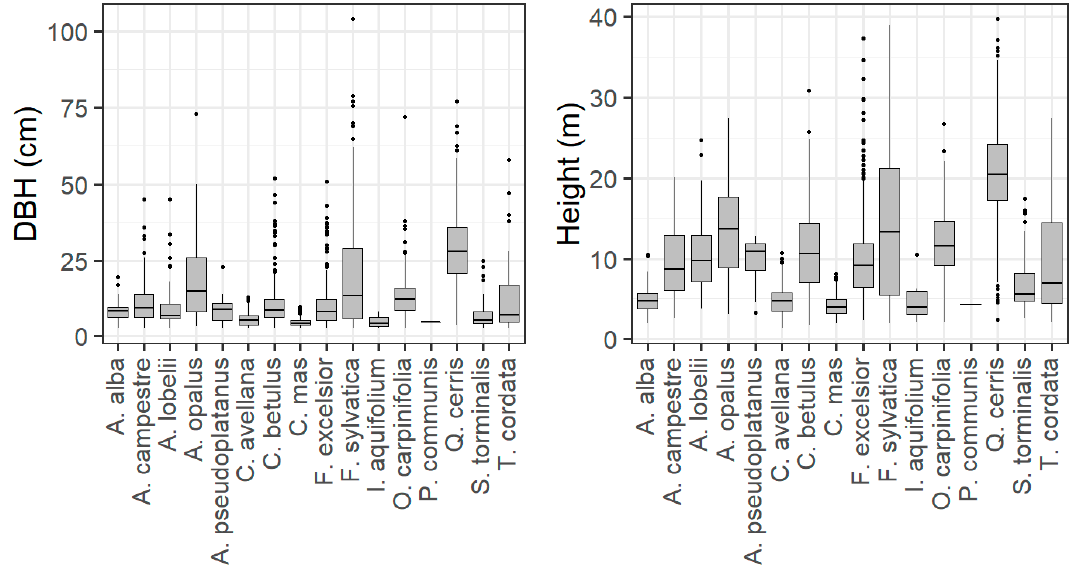
Figure A1. Tree diameter and tree height distribution per tree species.